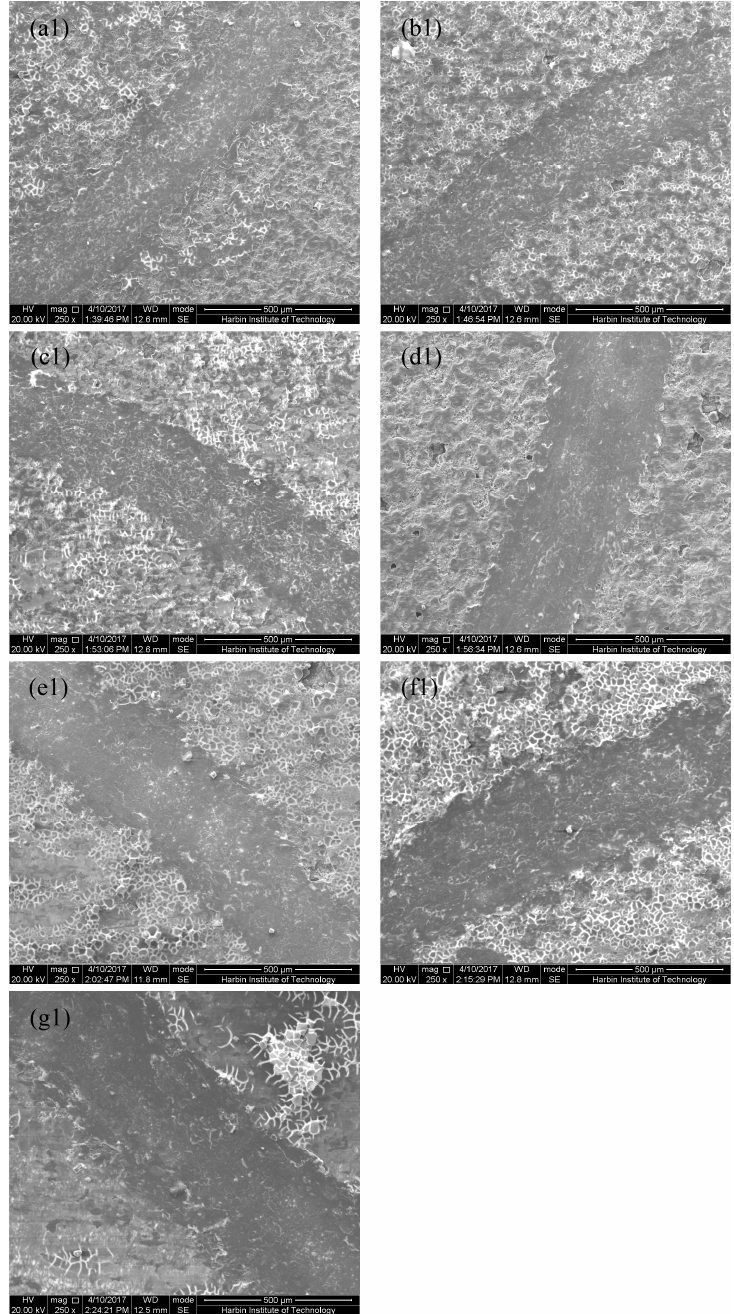
Figure 16. The morphologies of wear tracks for the MAO self-lubricating composite coatings formed on aluminum alloys at different anode pulse-widths. ( a1 ) 1000 μ s; ( b1 ) 1500 μ s; ( c1 ) 2000 μ s; ( d1 ) 2500 aluminum alloys at different anode pulse-widths. ( a1 ) 1000 µ s; ( b1 ) 1500 µ s; ( c1 ) 2000 µ s; ( d1 ) 2500 µ